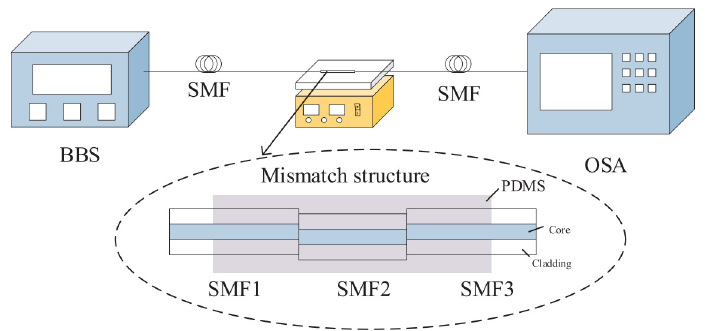
Figure 8. Experimental setup of coated polydimethylsiloxane based MZI temperature sensor [72]. Reprinted with permission from Ref. [72]. Copyright 2019 Elsvier Science and Technology Journals.